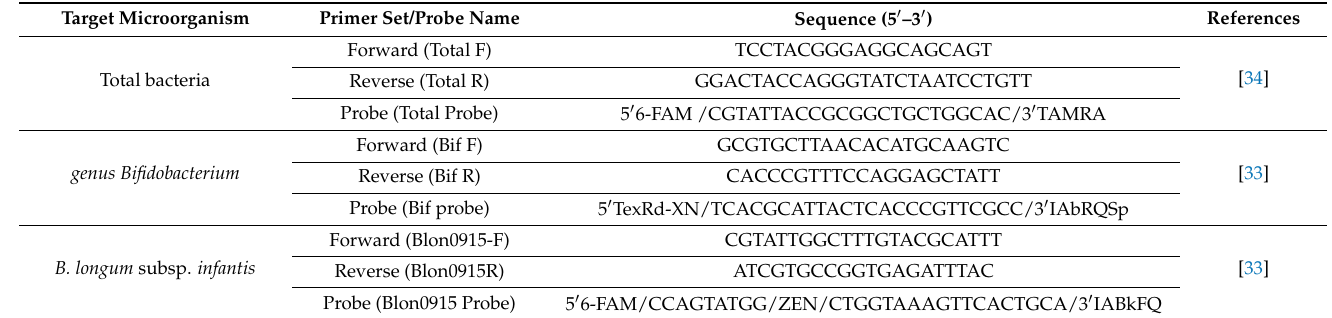
Table 1. Primers used in this